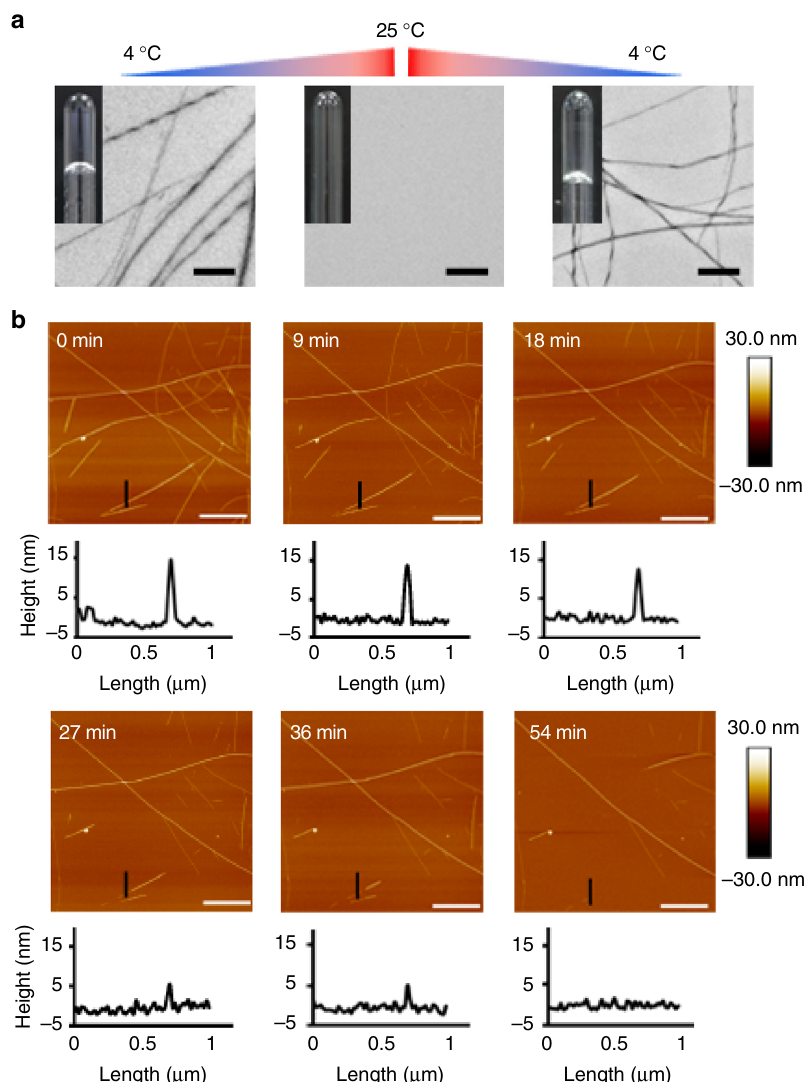
Fig. 2 Reversible amyloid fi brils formed by hnRNPA1 RAC1. a Reversible amyloid fi brils and hydrogels formed by hnRAC1 regulated by temperature. Amyloid fi brils were imaged by TEM. Scale bars are 500 nm. b Montage of real-time and in situ visualization of the self-dissociation of hnRAC1 fi brils by AFM. The black short line on AFM images indicates the cross-section that is analyzed below. The bright spot on AFM images indicates the imaging position. Scale bars are 2.0 μ